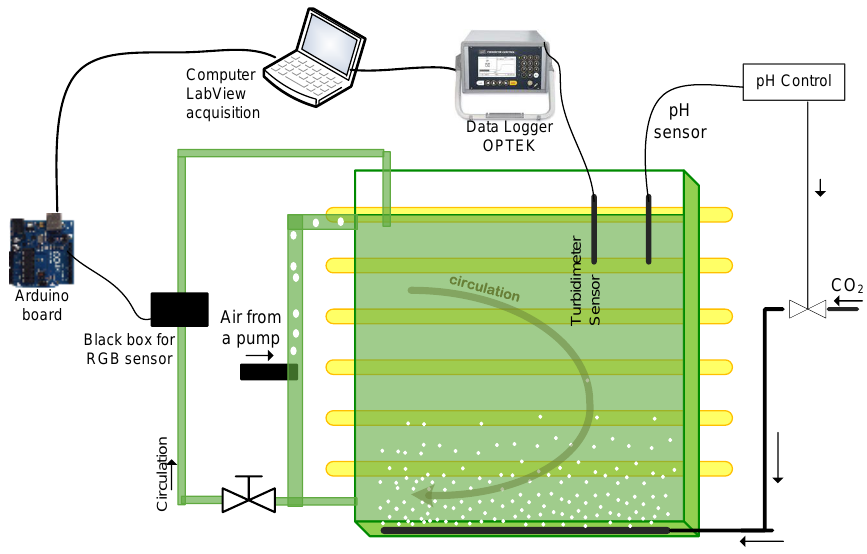
Figure 7. Schematic representation of the plant for microalgae culture.